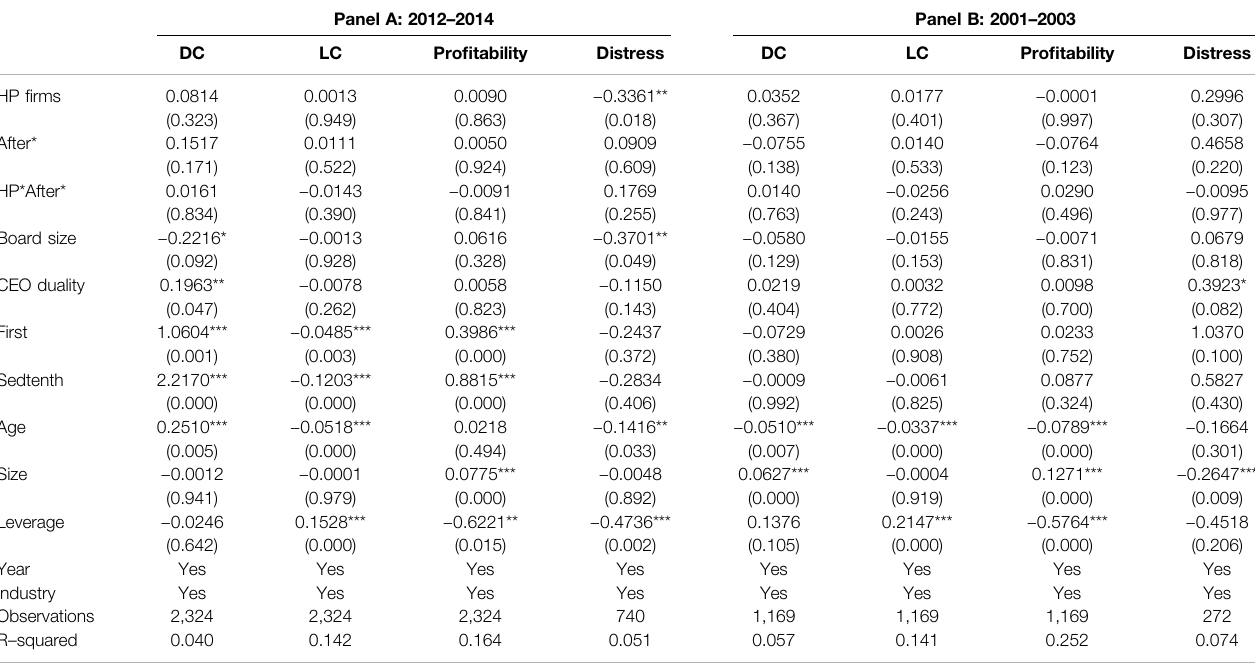
TABLE 6 | Robustness test-parallel trend assumption. This table presents the results of robustness test-parallel trend assumption. After* is adopted to replace After and re-estimate the in fl uence of environmental protection fee on fi rm performance for the sample periods of 2012 – 2014 and 2001 – 2003. After* is a dummy variable, which equals 1 for fi rm-year observations after 2013 and 2002, and 0 otherwise. For the probit regression (column Distress), we report the marginal effect rather than the coef fi cients. For the de fi nitions of variables refer to Appendix A . P -values are in